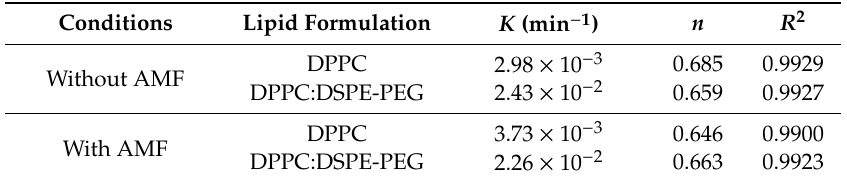
Table 8. Parameters of the Korsmeyer–Peppas model for the release of curcumin from SMLs in the presence and absence of an AMF.